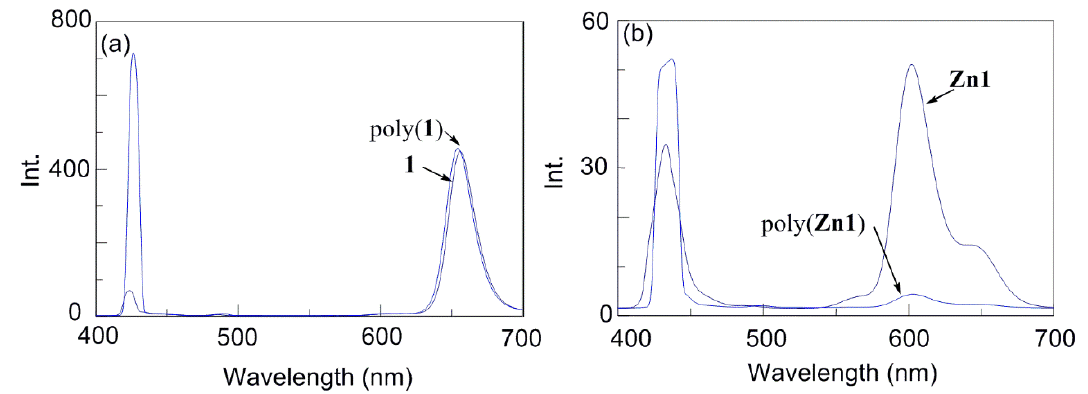
Figure 4. Fluorecence spectra of ( a ) 1 and poly( 1 ), excited at 420 nm; ( b ) Zn1 and poly( Zn1 ), excited at 425 nm ( Zn1 ), excited at 430 nm (poly( Zn1 )); in THF at 20 ◦ C, cell length = 10 mm, c = 0.5 × 10 − 6 M based on porphyrin unit).